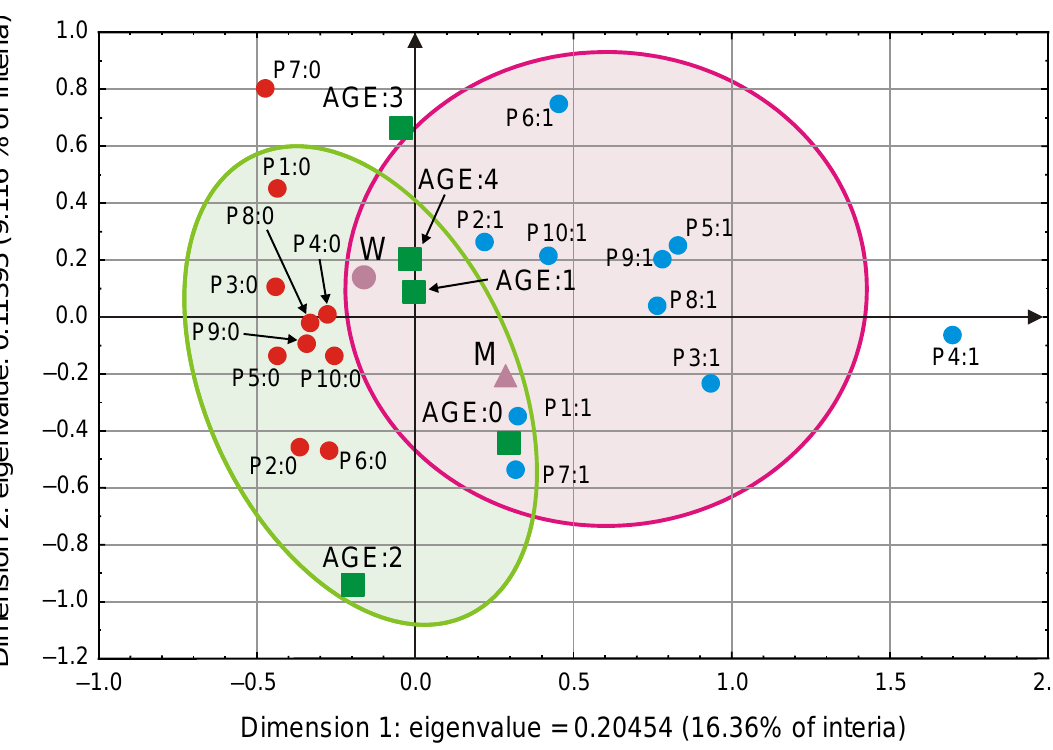
Figure 5. Two-dimensional plot of column coordinates—dimension 1 × 3. Input table (rows × columns): 27 × 27 Burt Table.